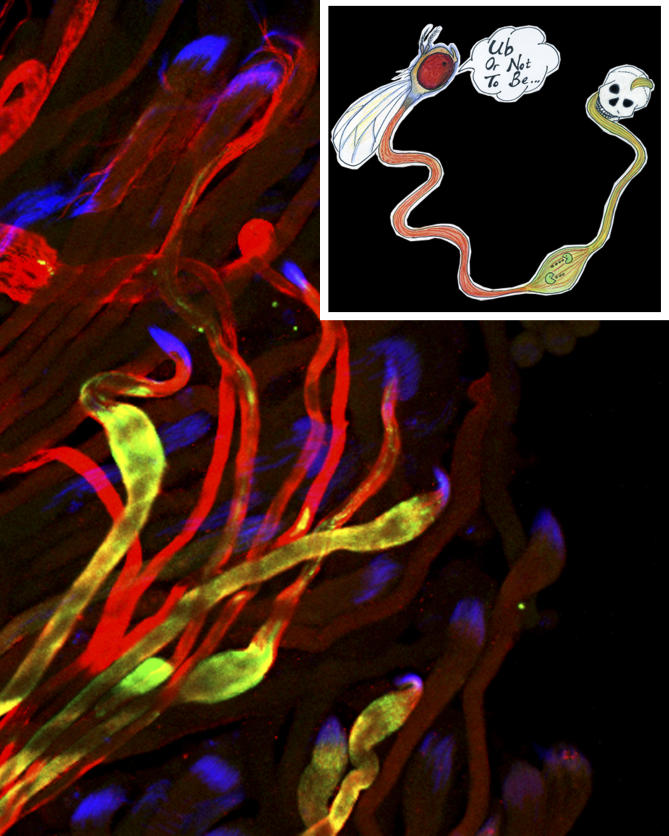

Drosophila spermatid “individualization” requires cell death proteins, including activated apoptotic effector caspases (stained green), and radically changes the cellular architecture. Individualizing spermatid tails are marked by the red staining of polyglycylated axonemal tubulin; the nuclear bundles are in blue.(Inset cartoon drawn by Anat Florentin and written by Yosef Kaplan, both in the Department of Molecular Genetics at The Weizmann Institute of Science)